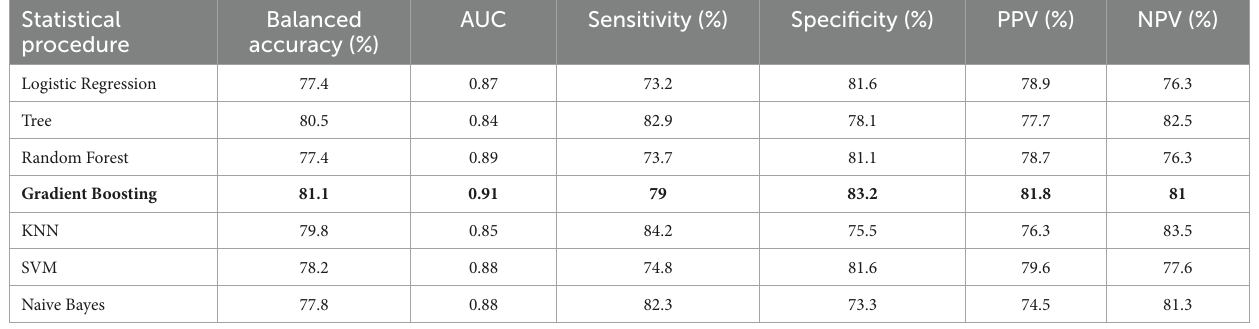
TABLE 3 ML models and their performance measures in nested cross-validation.